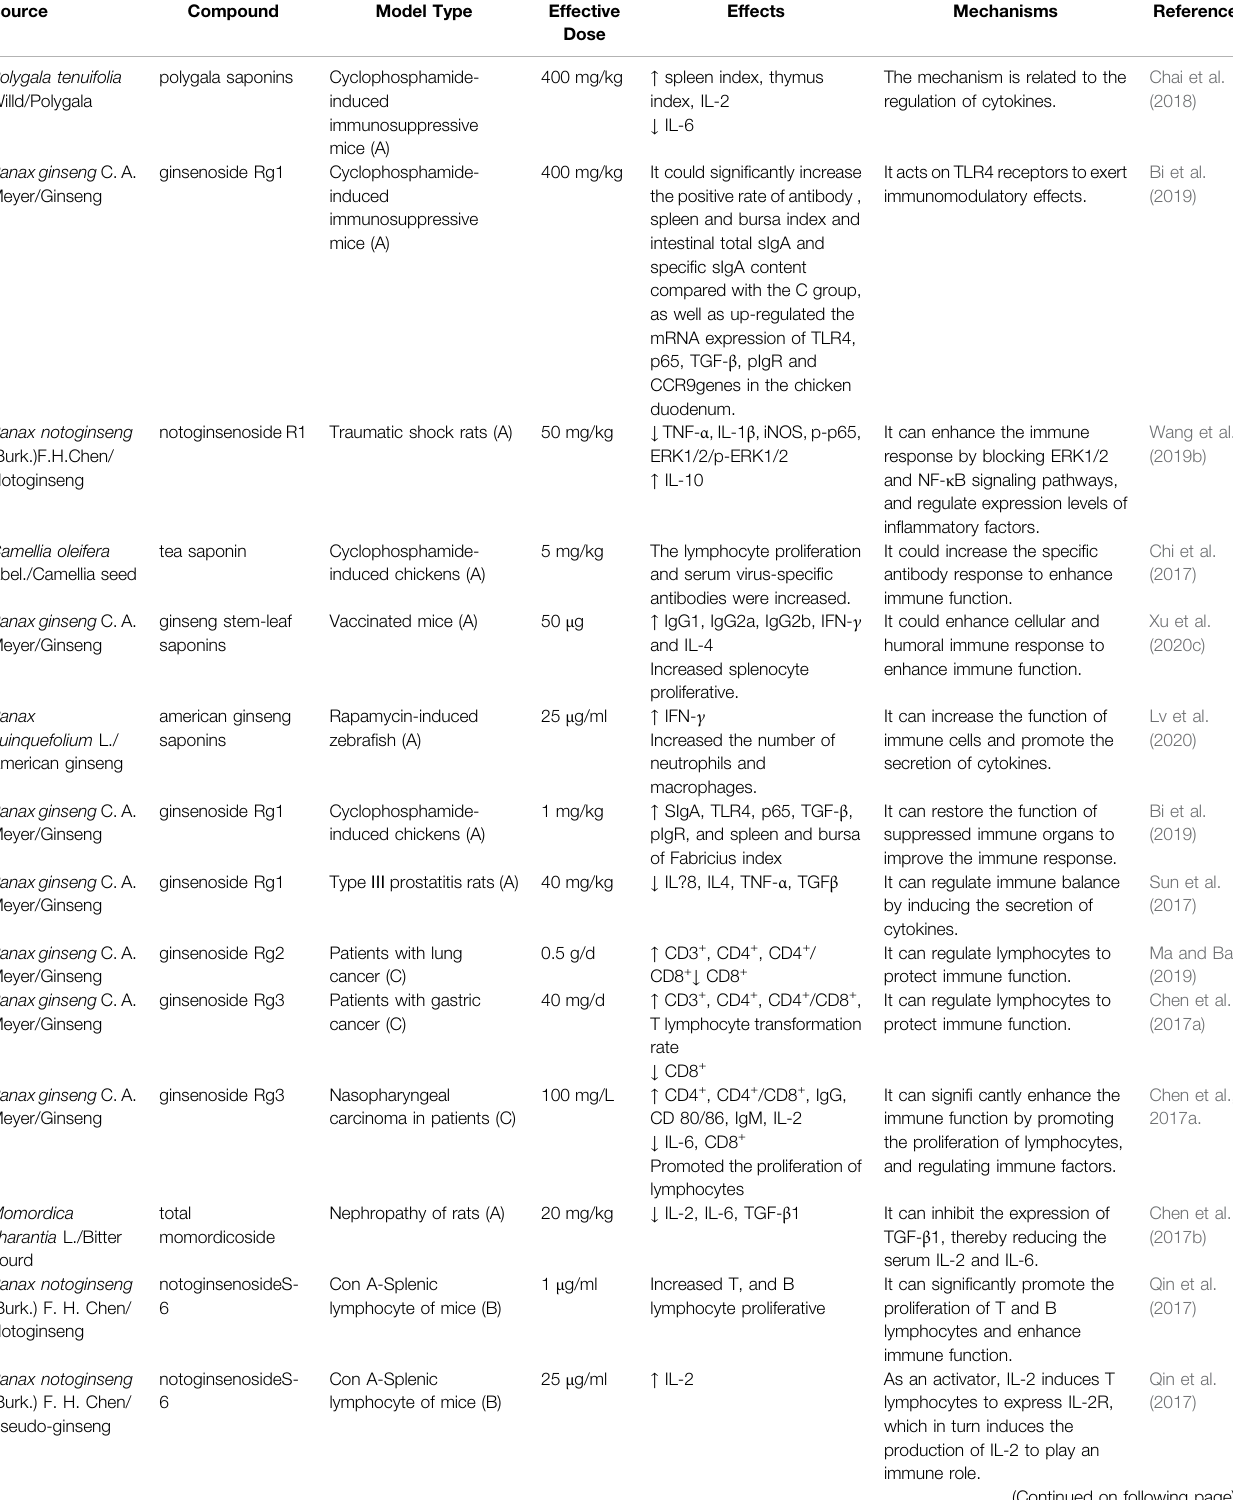
TABLE 2 | Experiment of saponins in plant-based functional foods on immune